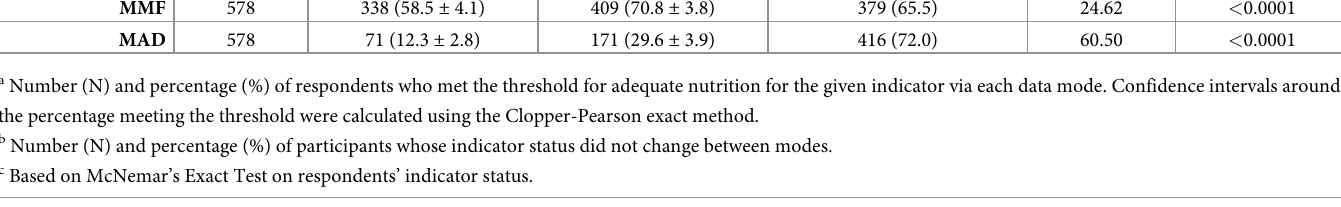
Survey mode had inconsistent effects on measured prevalence of adequate diet in the sampled population (Table 2). Mode had no effect on prevalence of adequate dietary diversity in women of reproductive age (MDD-W) (Difference = 1.5% ± 2.2%, two-tailed Z = 0.692, p = 0.49). However, inferred prevalence of adequate dietary diversity for infants and young children (MDD) changed with mode, with 17.8% ± 2.6% higher prevalence of adequate dietary diversity measured via CATI (two-tailed Z = 6.738, p < 0.00001). Similarly, the inferred preva- lence of adequate meal frequency for infants and young children (MMF) was 12.3% ± 2.8% higher via CATI than F2F (two-tailed Z = 4.404, p = 0.00001). Similar to MDD and MMF, the compound metric MAD showed a difference in inferred prevalence with mode; it was 17.3% ± ment in individual indicator status with mode was approximately 70%. For participants who the prevalence of adequate diet with round for women of reproductive age (MDD-W) or infants and young children (MAD), and the rate of agreement in individual indicator status between rounds was somewhat higher than between modes at 80% (S3 Table).